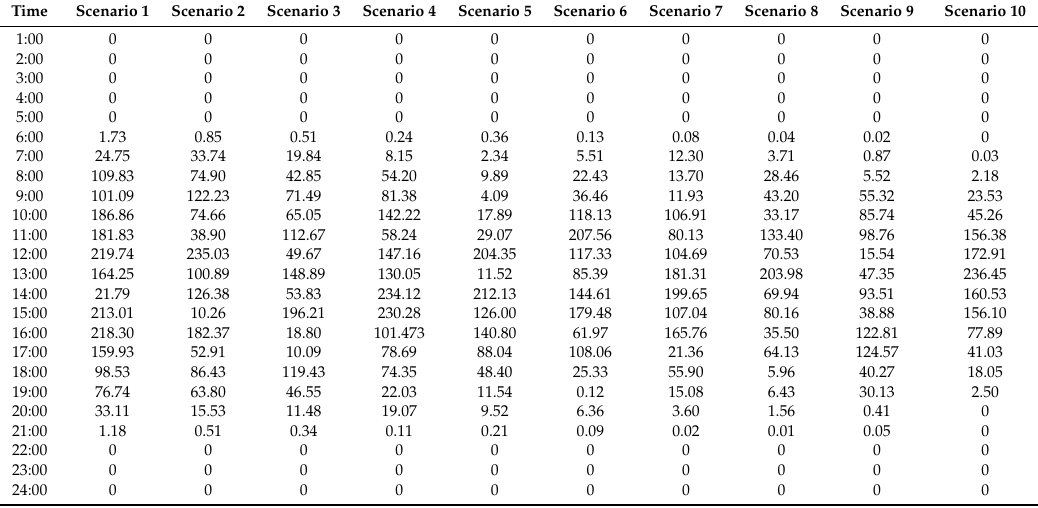
Table 3. PV output power (kW) at each scenario and each time.